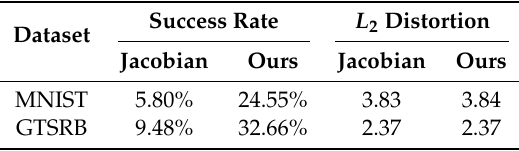
Table 3. Effect of non-targeted attack.